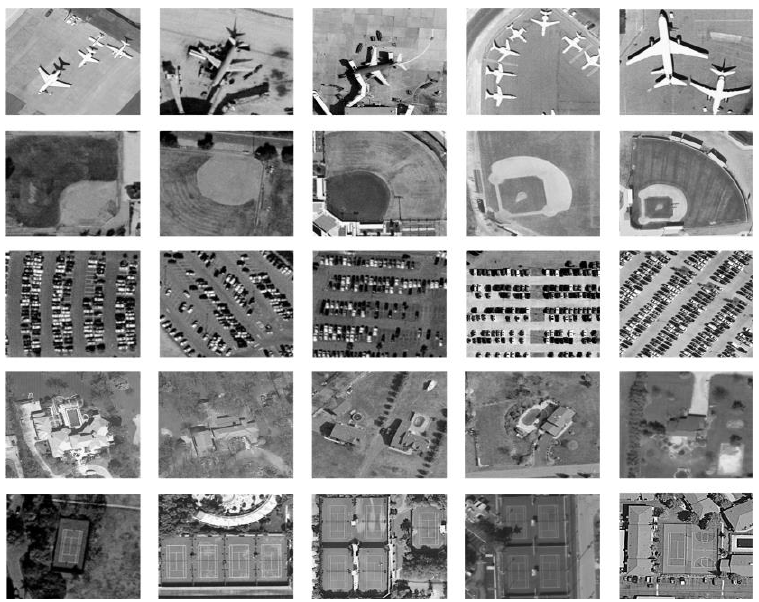
Figure2. Some image patches of retrieval